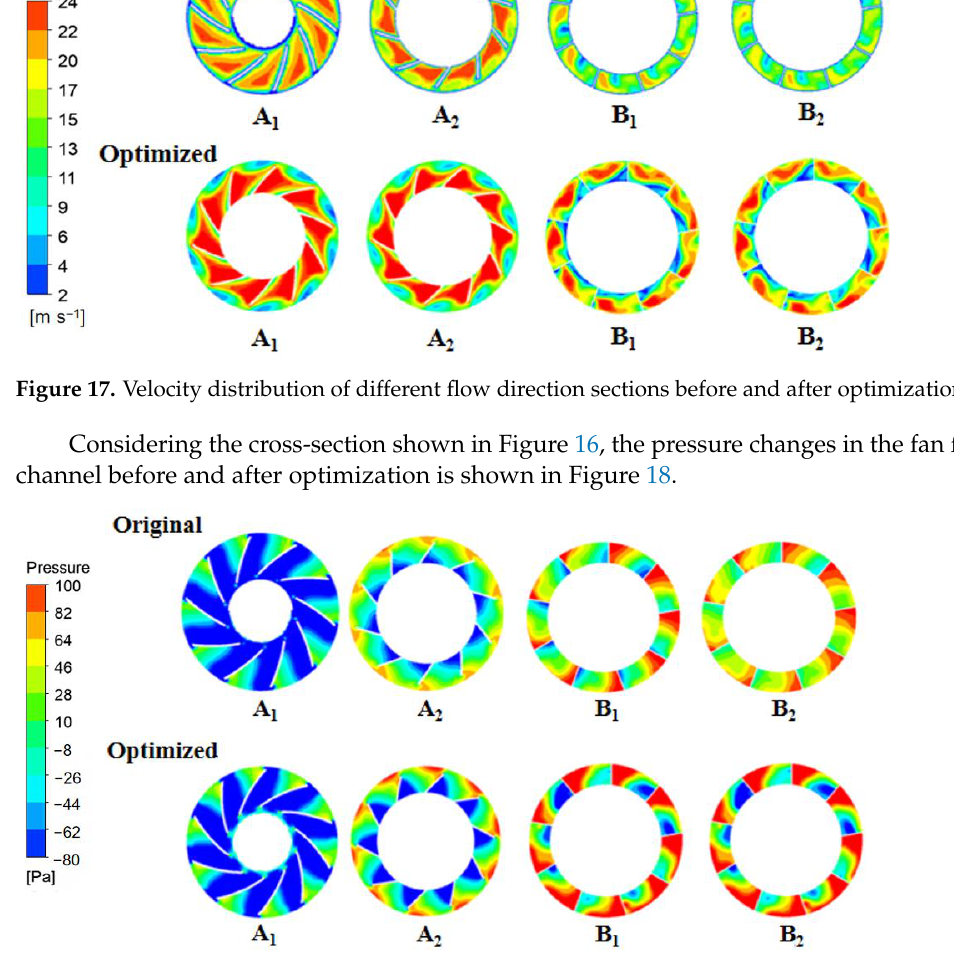
Figure 18. Pressure distribution of different streamwise sections before and after optimization.